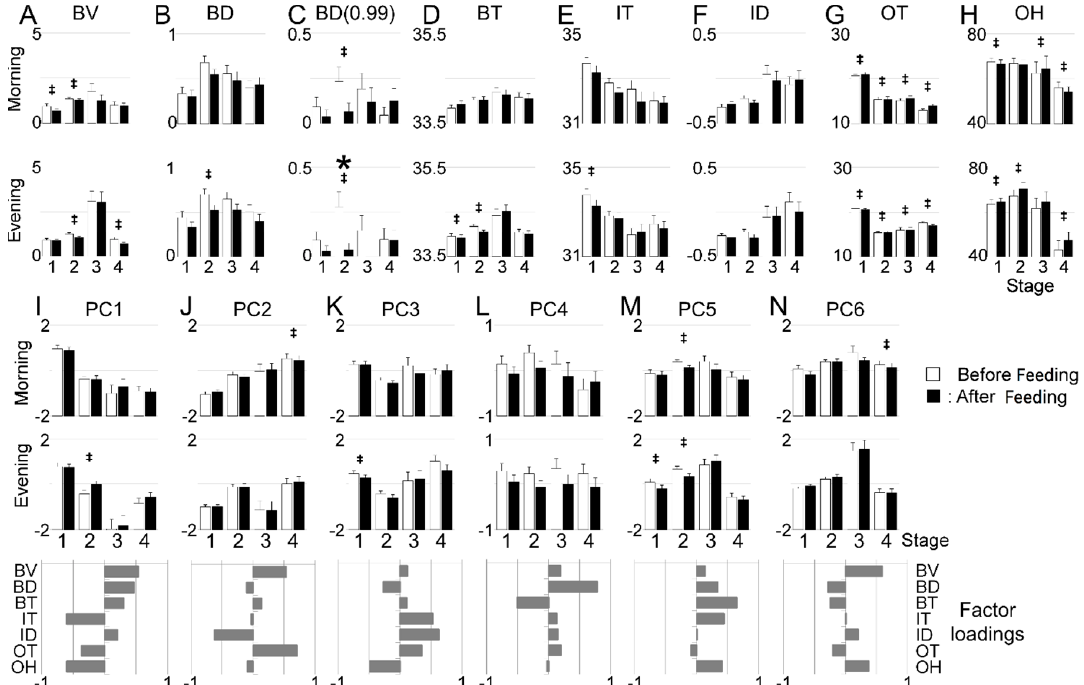
Figure 4. Comparison of each 30-min variable average before and after feeding. All variables ( A – H ) and PC scores characterized by factor loadings ( I – N ) are compared. * p < 0.05 by Tukey’s HSD test following two-way ANOVA. ‡ p < 0.05 by paired t-test.